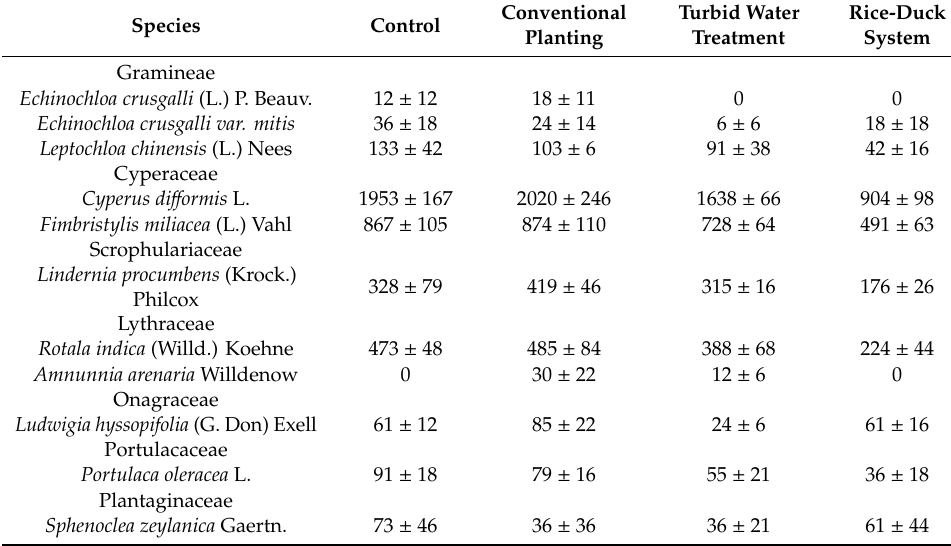
Table 1. Soil seed bank composition (individuals m − 2 ) under di ff erent treatments in the early season of rice growth. Conventional Species Control